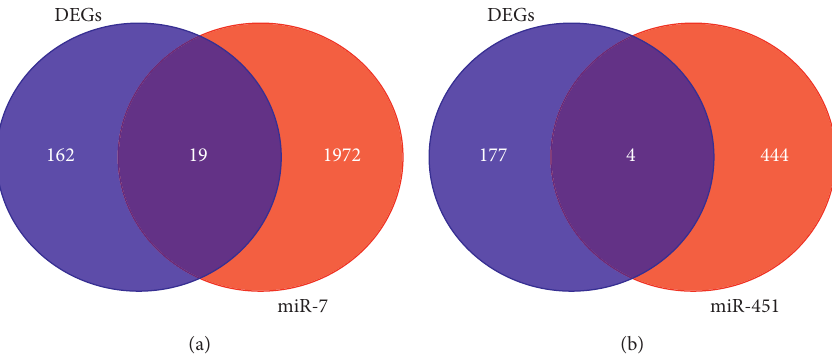
Figure 5: (a) VENN diagram identified the consistent genes between the DEGs and the target genes of miRNA-7. (b) VENN diagram identified the consistent genes between the DEGs and the target genes of